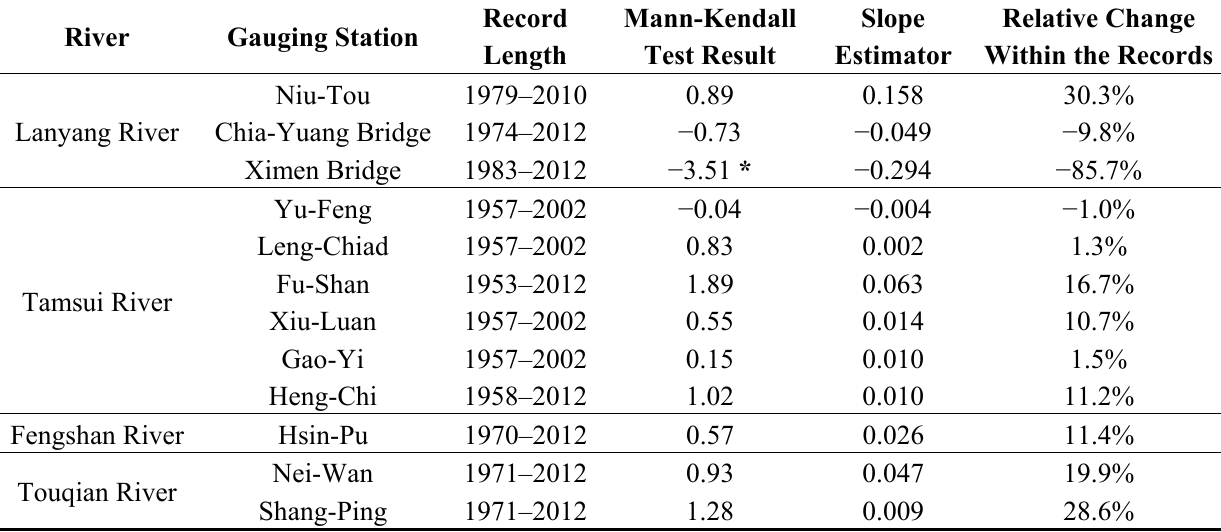
Table 2. Results of Mann-Kendall test, slope estimators, and relative